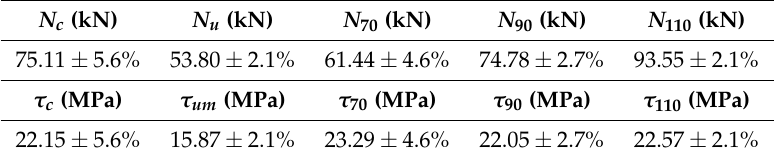
Table 2. Experimental results of tests on systems with different